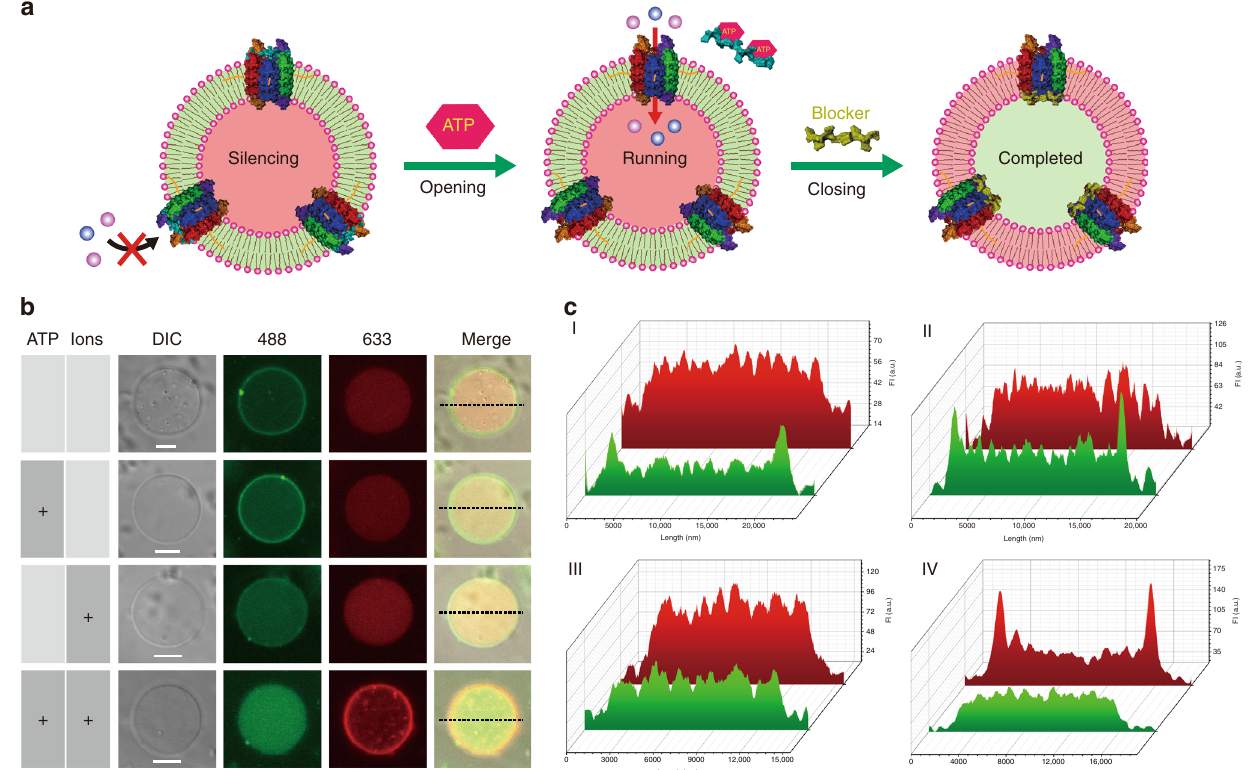
Fig. 5 Characterization of arti fi cial molecular signaling system. a Schematic illustration of AMSsys working principle. Initially, chol-c-DNGK with biomimetic GPMV effectively shields the extracellular zinc ions. Driven by ATP, however, chol-c-DNGK switches to the open state, allowing ions to freely fl ow into the chamber by diffusion and trigger the signaling network. Eventually, the feedback pathway mediates chol-o-DNGK to switch back to the original closed state. Simultaneously, reactions of con fi ned signaling network have been accomplished. b CLSM analysis of AMSsys in the above different states. Panel 1: without ATP and ions. Con fi ned signaling network stays inactivated: Cy5-labeled (633 channel) blocker is free in the chamber, where the 488 signal saw only minor increase. Panel 2: Addition of ATP drives the opening of chol-c-DNGK, while the signaling network continues to remain inactive by the absence of ion in fl ux triggering. Panel 3: Addition of only ions (no ATP) cannot trigger the con fi ned reactive network and chol-DNGK remains closed. Panel 4: Only in the presence of both ATP and ion in fl ux, can all designed reactions be completed: chol-c-DNGK switches to chol-o-DNGK, followed by diffusion of ions through the mimetic nanochannel, triggering, in turn, the con fi ned signaling network. After completion of the con fi ned reaction cascade, the fl uorescent signal from SG-I is revealed (light green spot) and Cy5-labeled blocker plugs the nanogatekeeper (red circle). Plus ( “ + ” ) mark denotes that the corresponding trigger (ATP or/and ions) was present. Scale bar, 5 μ M. c Fluorescence intensity of the white dashed line section of each group in b . Groups I, II, III, and IV, respectively, represent the independent groups (from panel 1 to panel 4) in b from top to bottom. The green pattern shows the SG-I fl uorescence channel, while the red pattern shows the Cy5 fl uorescence channel. Source data are provided in the Source Data fi Methods Construction of DNA nanostructures . All DNA nanostructures were assembled in 1× TAE/Mg 2 + buffer (40 mM Tris, 20mM acetic acid, 1mM EDTA, pH = 7.4, 12.5mM Mg 2 + ) annealed from 95 to 4°C with the temperature gradient shown in Supplementary Table 4. The DNA sequence used for DNA nanogatekeeper design is shown in Supplementary Table 2, also see Supplementary Methods.